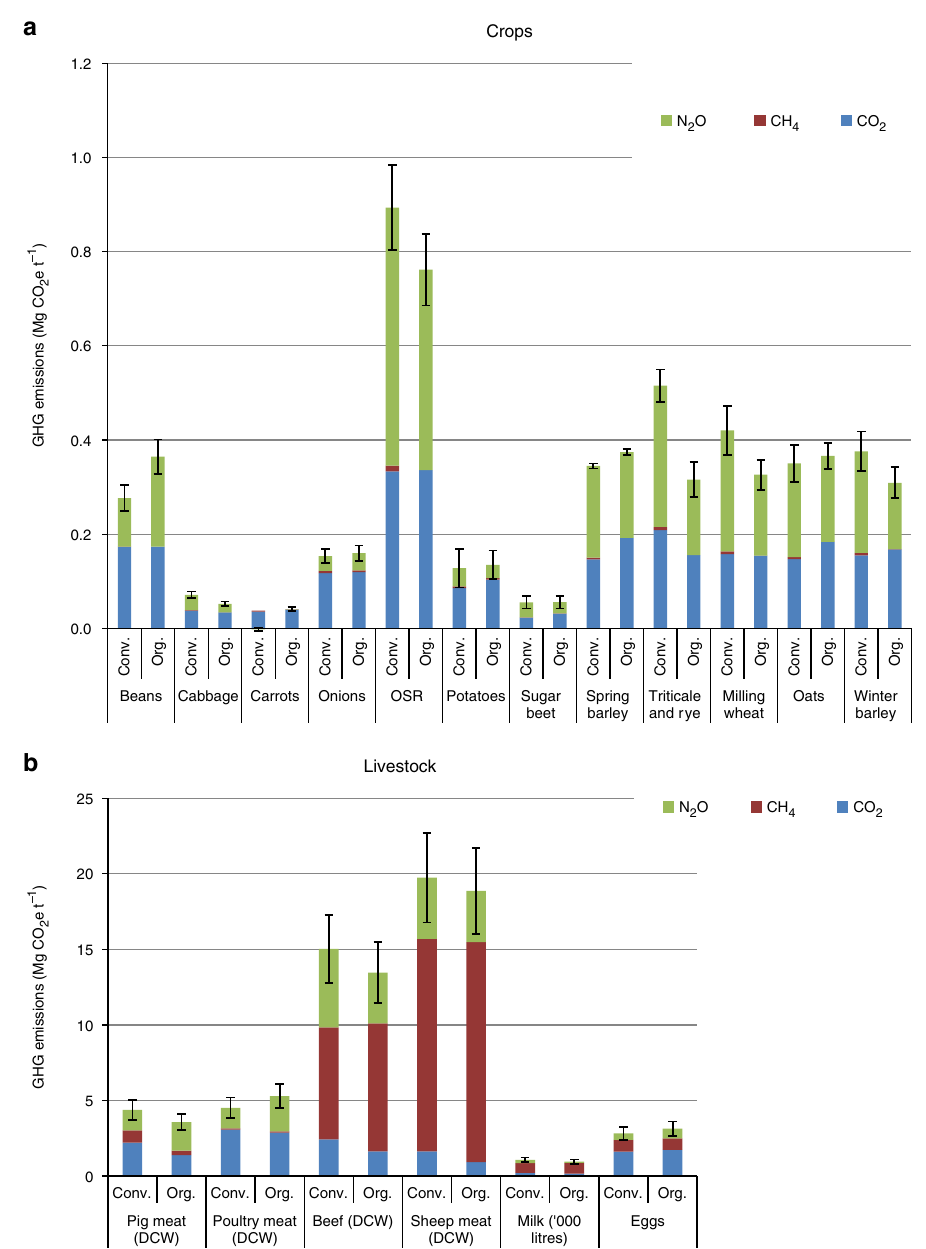
Fig. 2 GHG emissions per unit production under conventional and organic farming methods. a Crops. b Livestock, including emissions in feed production. N 2 O = nitrous oxide, CH 4 = methane, CO 2 = carbon dioxide. Production is expressed in tonnes (t) of total metabolised energy. Data are means ±1 standard deviations from the uncertainty analysis (Methods). Emissions due to land use change overseas to compensate for shortfalls in home production, and enhanced soil carbon sequestration under organic methods, are not allowed for. Organic dairy, beef and sheep production have lower total GHG emissions per tonne of product, although greater forage intake increases CH 4 emission. Less N fertiliser use in organic farming gives N 2 O and fossil energy use savings per tonne of product. Exceptions are crops receiving less N fertiliser in conventional farming (beans, oats), organic crops requiring fl ame weeding (carrots) and organic vegetable crops with lower marketable yields (potatoes, onions). Source Data are provided as a Source Data fi